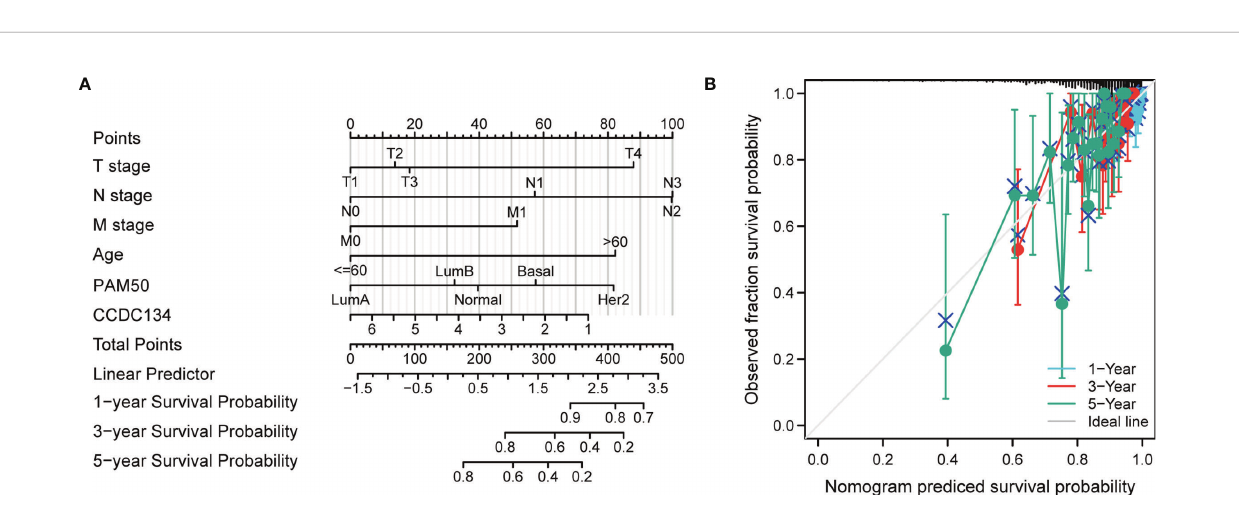
FIGURE 6 | Construction of a rosette to predict the probability of survival in BRCA patients. (A) Nomogram to predict 1 -, 3 -, and 5-year BRCA survival probabilities consisting of CCDC134 and independent clinical risk factors. (B) Nomograms calibrated to predict the probabilities of 1 -, 3 - and 5-year survival. The gray line represents actual survival.